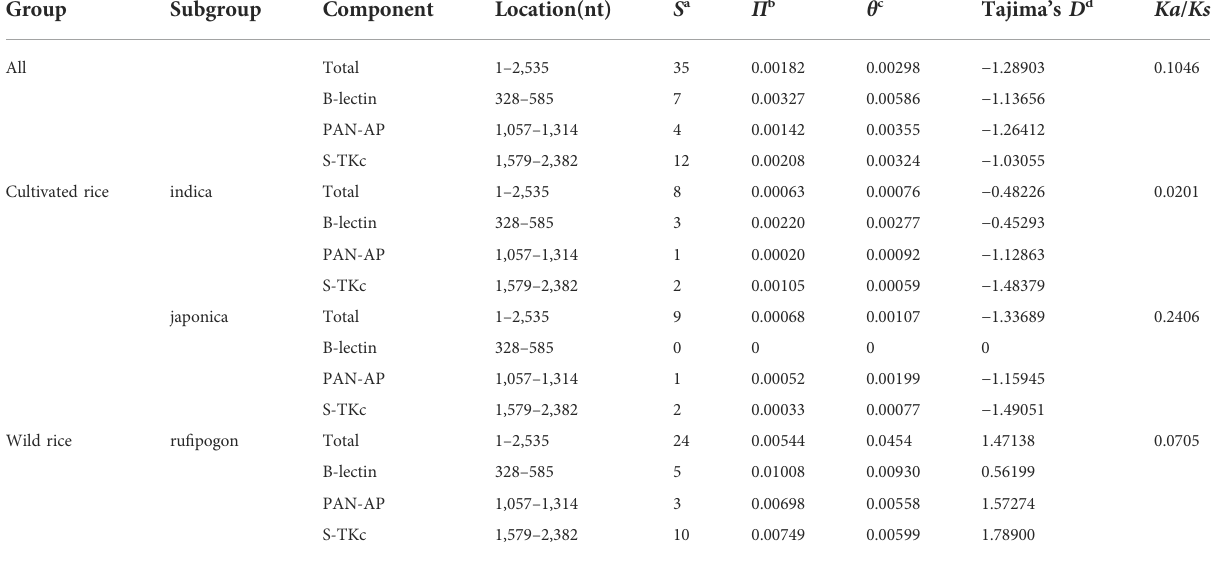
TABLE 2 Nucleotide polymorphism of the Pi-d2 allelic